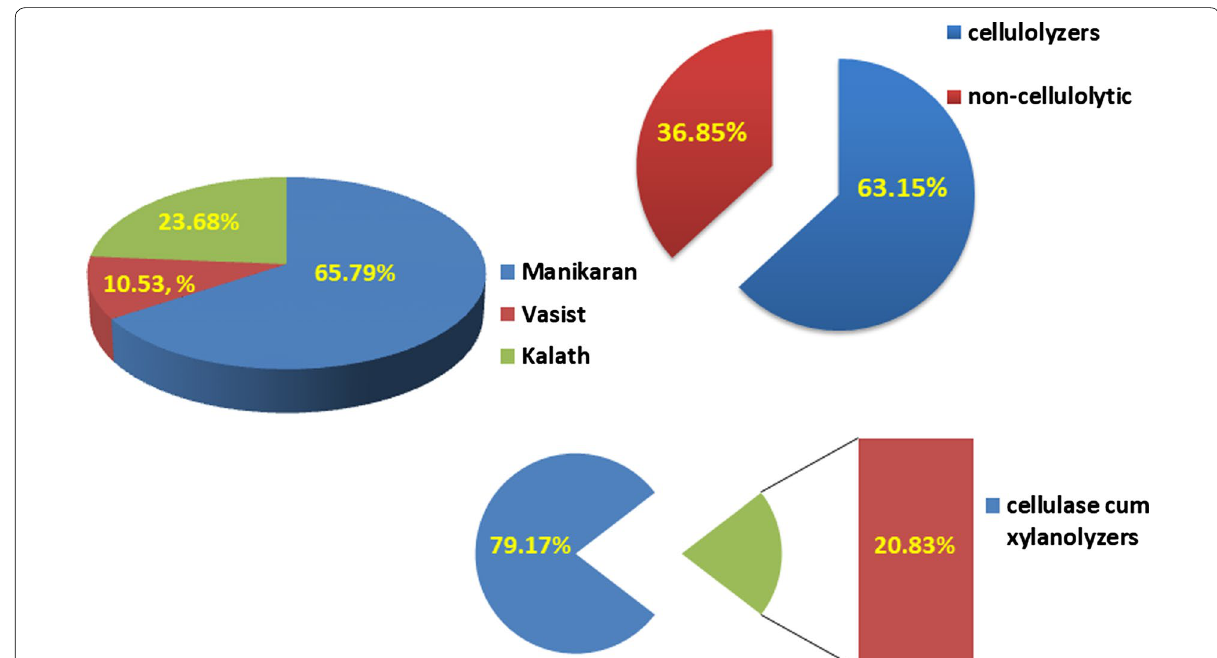
Fig. 1 Distribution of isolated thermophiles in hot springs of Himachal Pradesh. Thermophilic bacterial isolates were obtained from three hot springs Vasist, Kalath and Manikaran of Himachal Pradesh, India. The isolates were subjected to qualitative screening for cellulose utilization on CMC agar plates. Based on the hydrolytic capacity they were classified as cellulolytic and non-cellulolytic bacterial